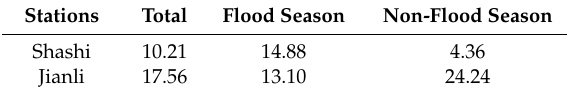
Table 4. Sectional averaged R -values of data measured after TGD dam operation.